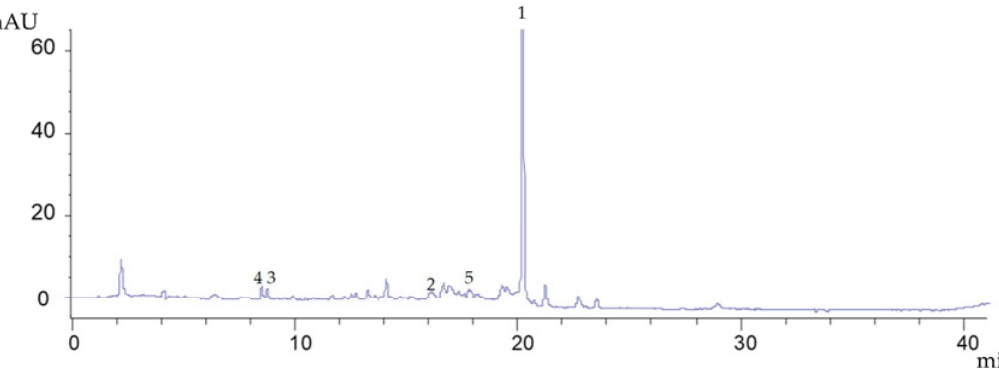
Figure 1. Chromatogram by HPLC-DAD at 280 nm of \ aqueous extracts of ‘Arbequina’ olive leaf, where 1: oleuropein; 2: verbascoside; 3: hydroxytyrosol; 4: hydroxytyrosol hexoside; and 5: apigenin-7- O -glucoside.